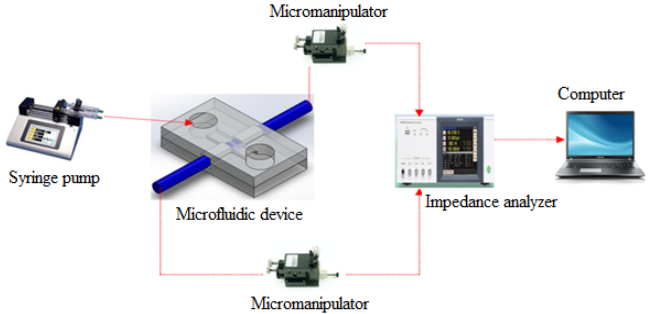
Figure 2. A schematic diagram of the experimental set ‐ up.